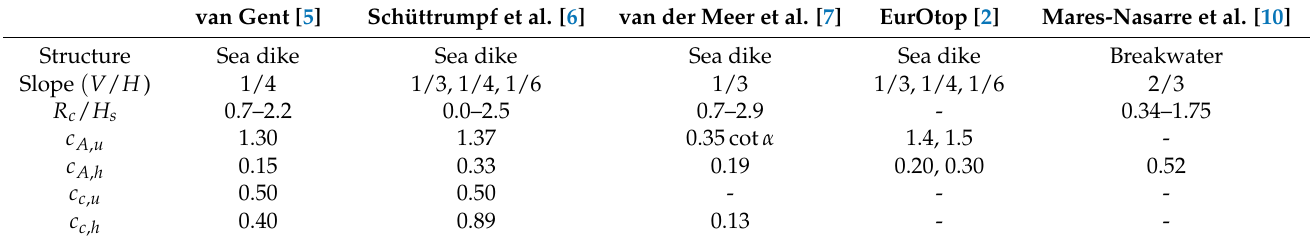
Table 1. Range of the applicability and empirical coefficients from the previous